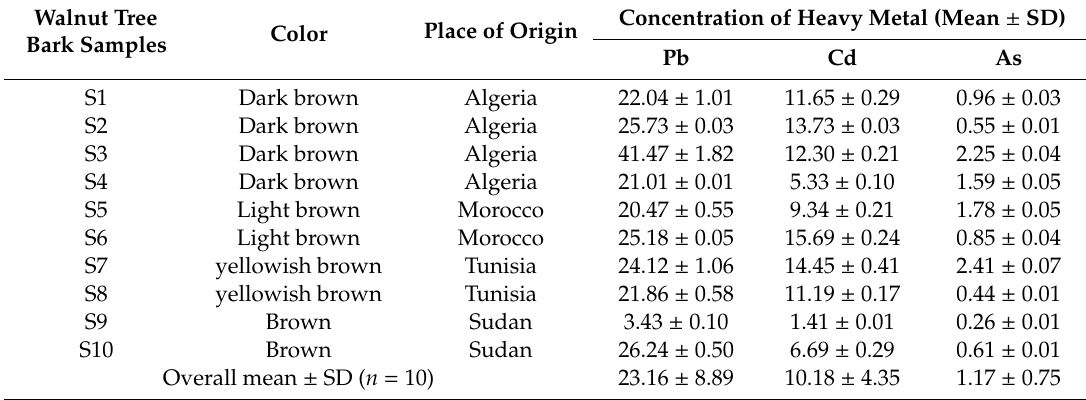
Table 7. Concentration levels of heavy metals ( µ g · g − 1 ) in the investigated walnut tree bark samples. Walnut Tree Bark Samples